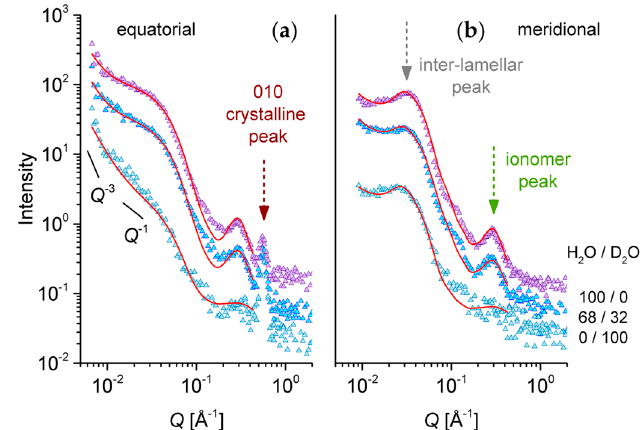
Figure 8. One-dimensional SANS patterns from the low sulfonated s-sPS film containing the co-crystalline δ -phase with protonated toluene and loaded with C60 fullerenes hydrated at relative humidity (RH) = 80% with different H 2 O/D 2 O ratios, as indicated in the right side of the plots. Experimental data (symbols) averaged over the equatorial ( a ) or meridian ( b ) directions are shown separately, with the lines corresponding to the model interpretation of the scattering profiles, as discussed in the text. The main structural features are indicated by arrows, while the solid lines in the panel (a) indicate the power law behavior of the scattering intensity in different Q ranges.